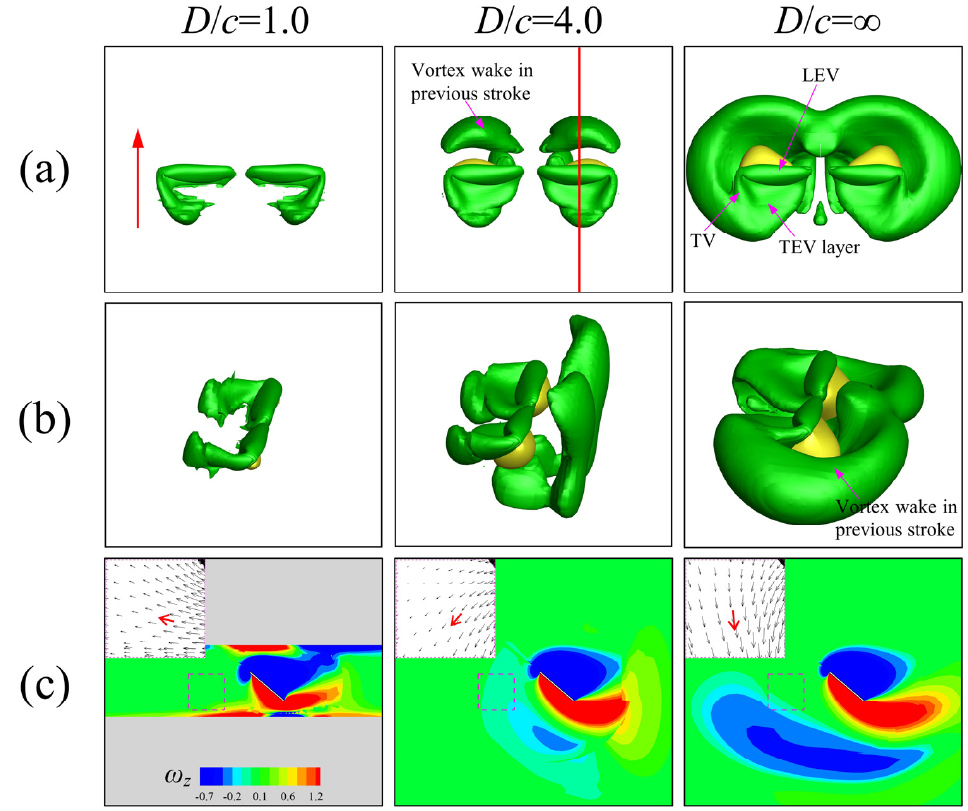
Figure 13. ( a ) Top view; ( b ) oblique view of the iso-Q surface (green) and iso-vertical velocity surface (yellow) showing the strength of downwash; and ( c ) spanwise vorticity distributions on a slice at τ = 0.25 for 𝐷 𝑐⁄ = 1.0, 4.0 and ∞ at 𝑅𝑒 = 10 . The red line in ( a ) gives the slice position. The red arrow in ( a ) indicates the stroke direction.